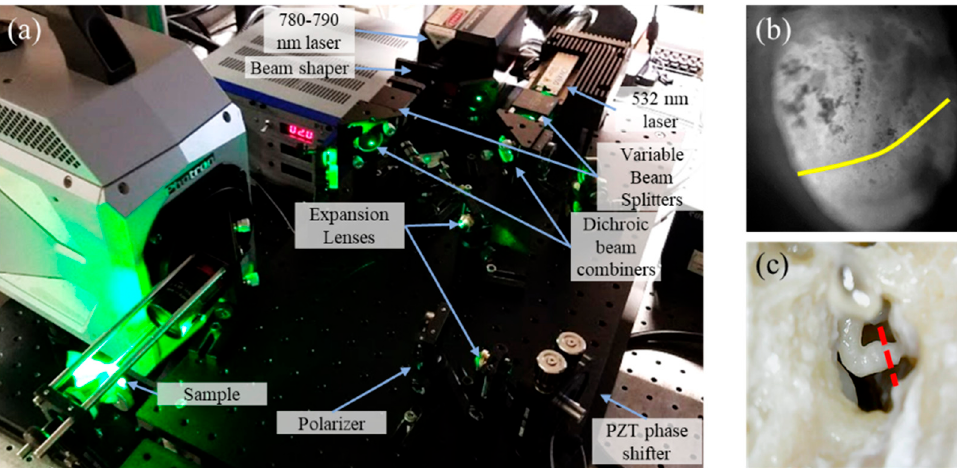
Figure 2. ( a ) Shows the setup, measuring instrumentations, and the sample; and ( b ) is a photograph of the human postmortem tympanic membrane (TM) with half level saline injected. The yellow contour shows the level of fluid. ( c ) Shows the incudo-stapedial (IS) joint. The red dash shows where the IS joint is interrupted.